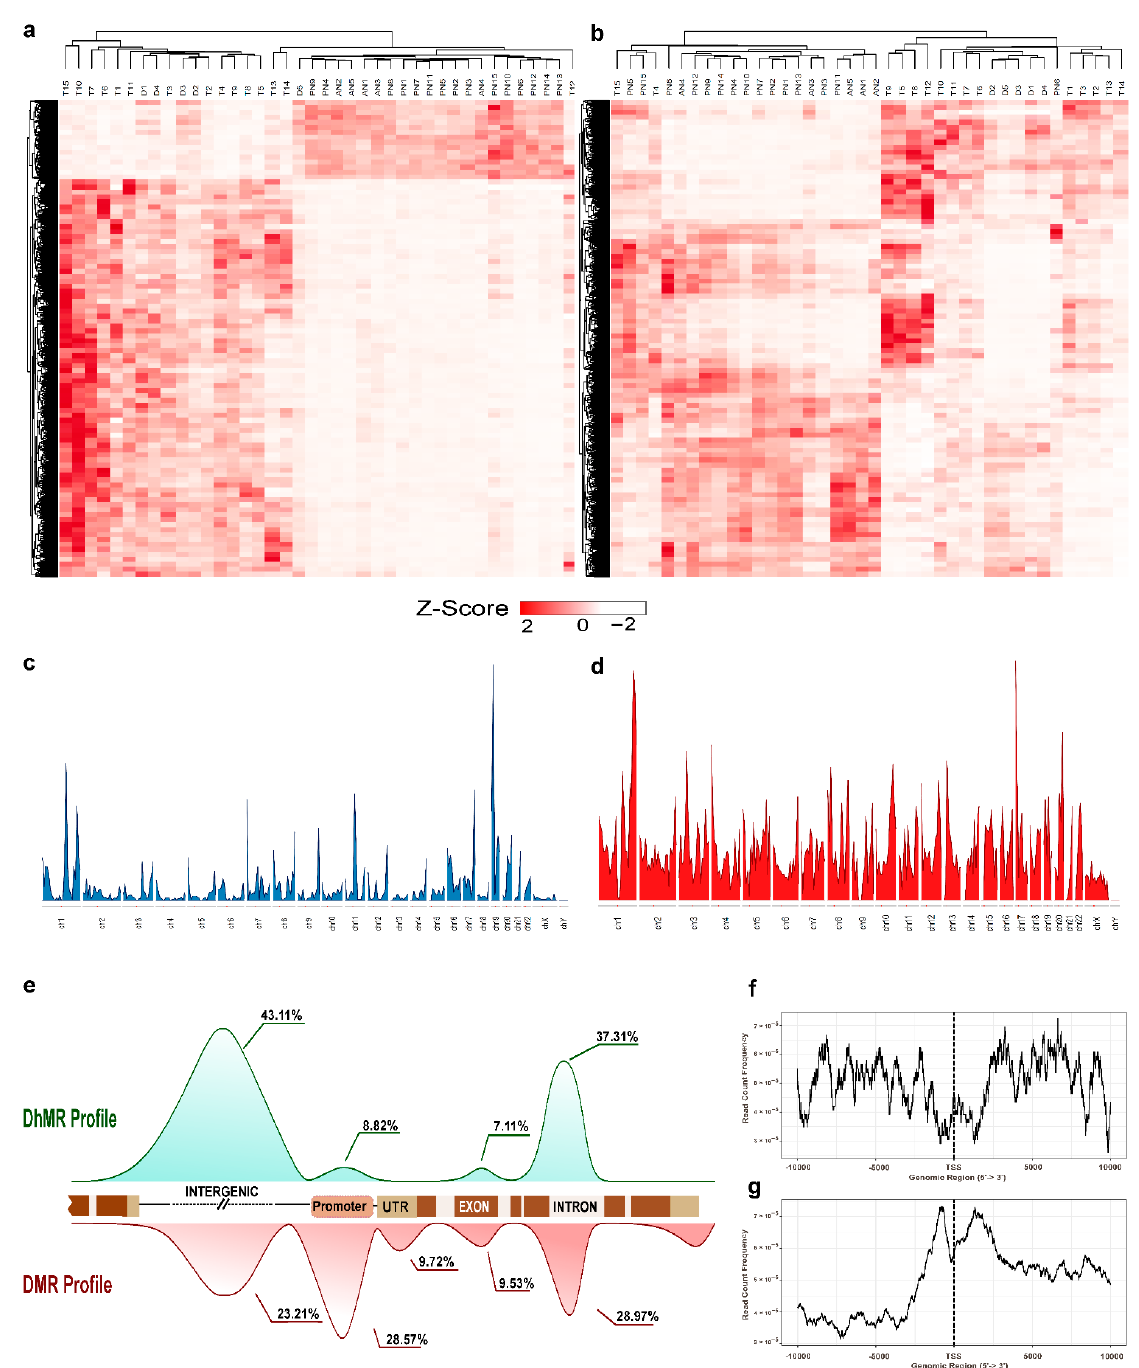
Figure 2. Genome-wide distribution of 5-mC and 5-hmC in breast cancer. ( a ) Heatmap representing DMRs in breast cancer. ( b ) Heatmap showing DhMRs in breast cancer (Z-score ranges from –2 (white) to +2 (red)). ( c ) Chromosomal distribution of differentially methylated regions (DMRs) in breast can- cer. ( d ) Chromosomal distribution of differentially hydroxymethylated regions (DhMRs) in breast cancer. ( e ) Genomic features of DMRs and DhMRs in breast cancer. ( f ) Relative peak count frequency of DhMR from Transcription Start Sites (TSSs). ( g ) Relative peak count frequency of DMR from TSSs.